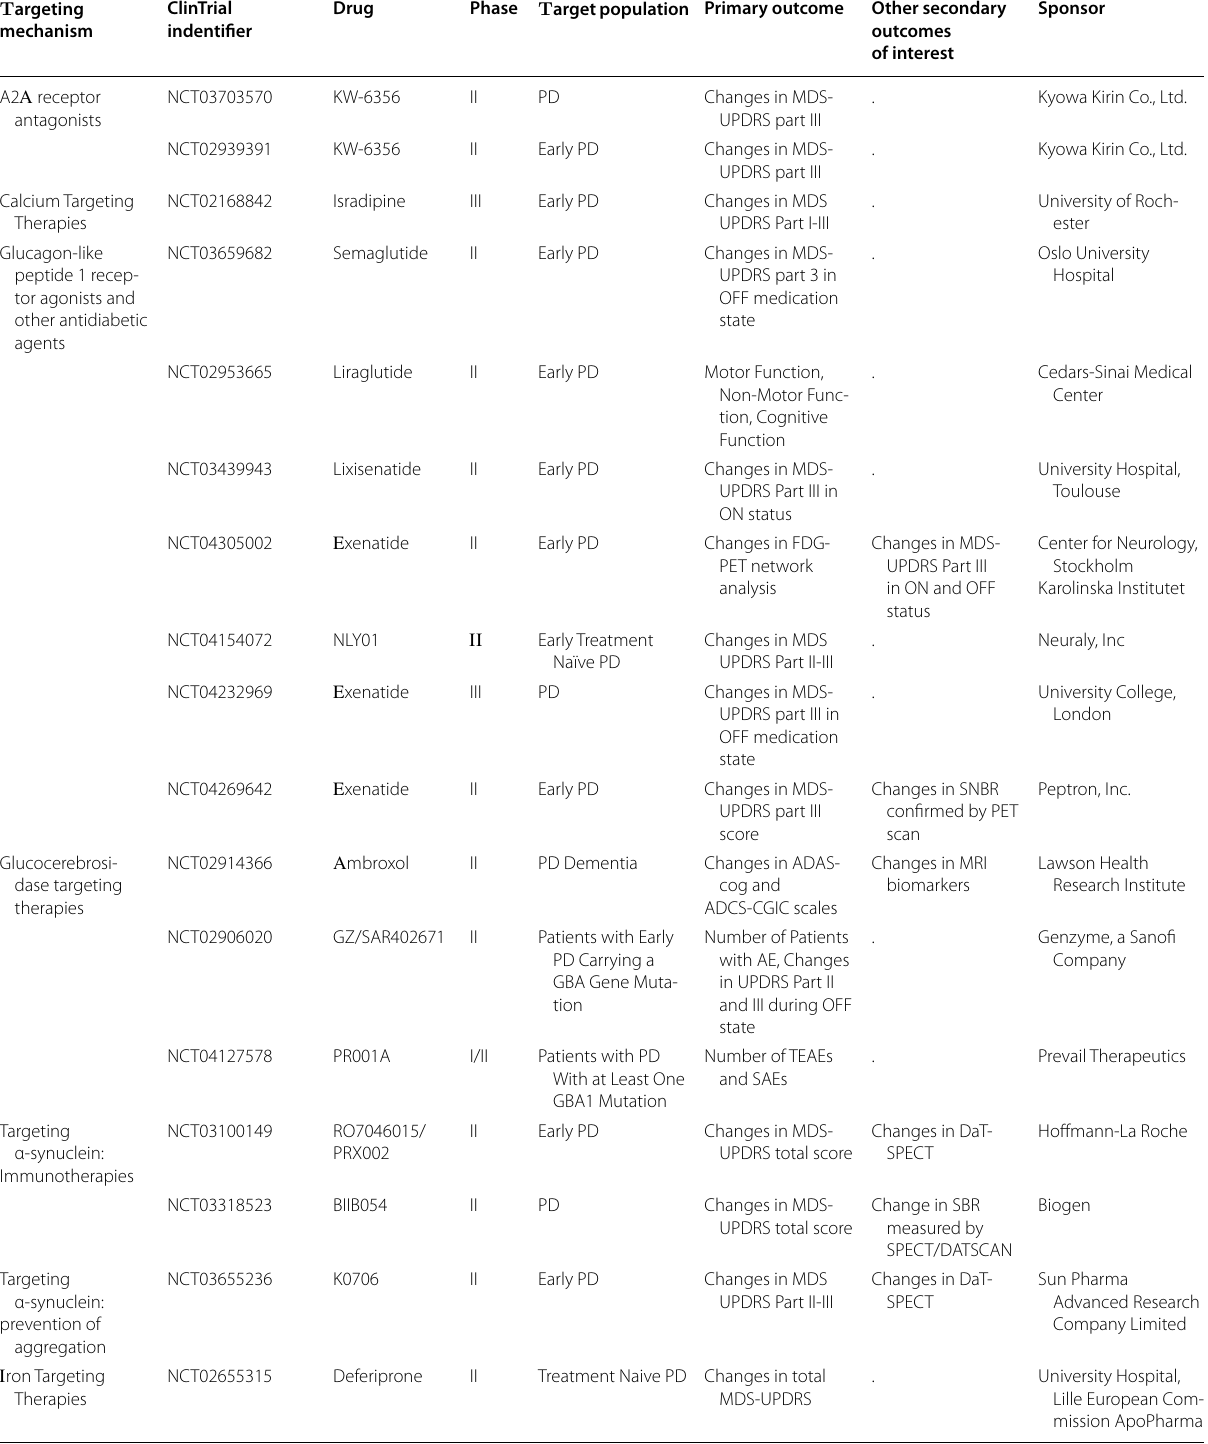
Table 2 Current pharmaceutical disease-modifying clinical trials phase II and